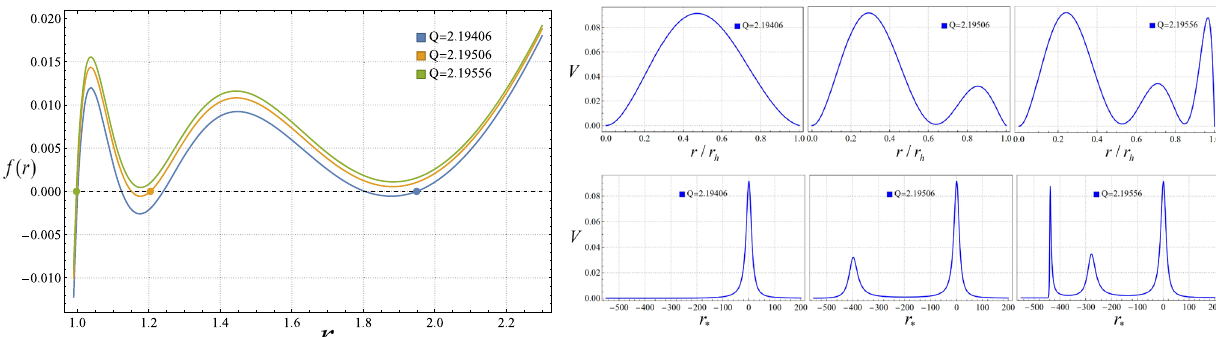
Fig. 1 The left panel shows three black holes in Einstein-nonlinear with Q = 2 . 1946 , 2 . 19506 , 2 . 19556respectively.Theupperrightpanel electrodynamic theory with α 1 = 1 ,α 2 = 0 . 39906 ,α 3 = 0 . 56367 , shows the corresponding effective potentials with respect to r h / r , and α = − 1 . 17846. α = 0 accord- the lower right panel shows the corresponding effective potentials with i > 4 is obtained by demanding that b i ≥ 17 4 ing to Ref. [28]. The blue, orange and green line represent black hole